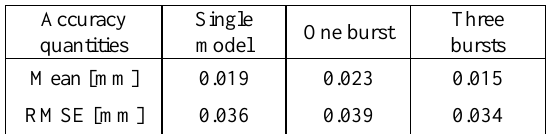
Table 9. Bias and RMSE of the estimated 𝑍 amplitudes between the photogrammetric system and the laser